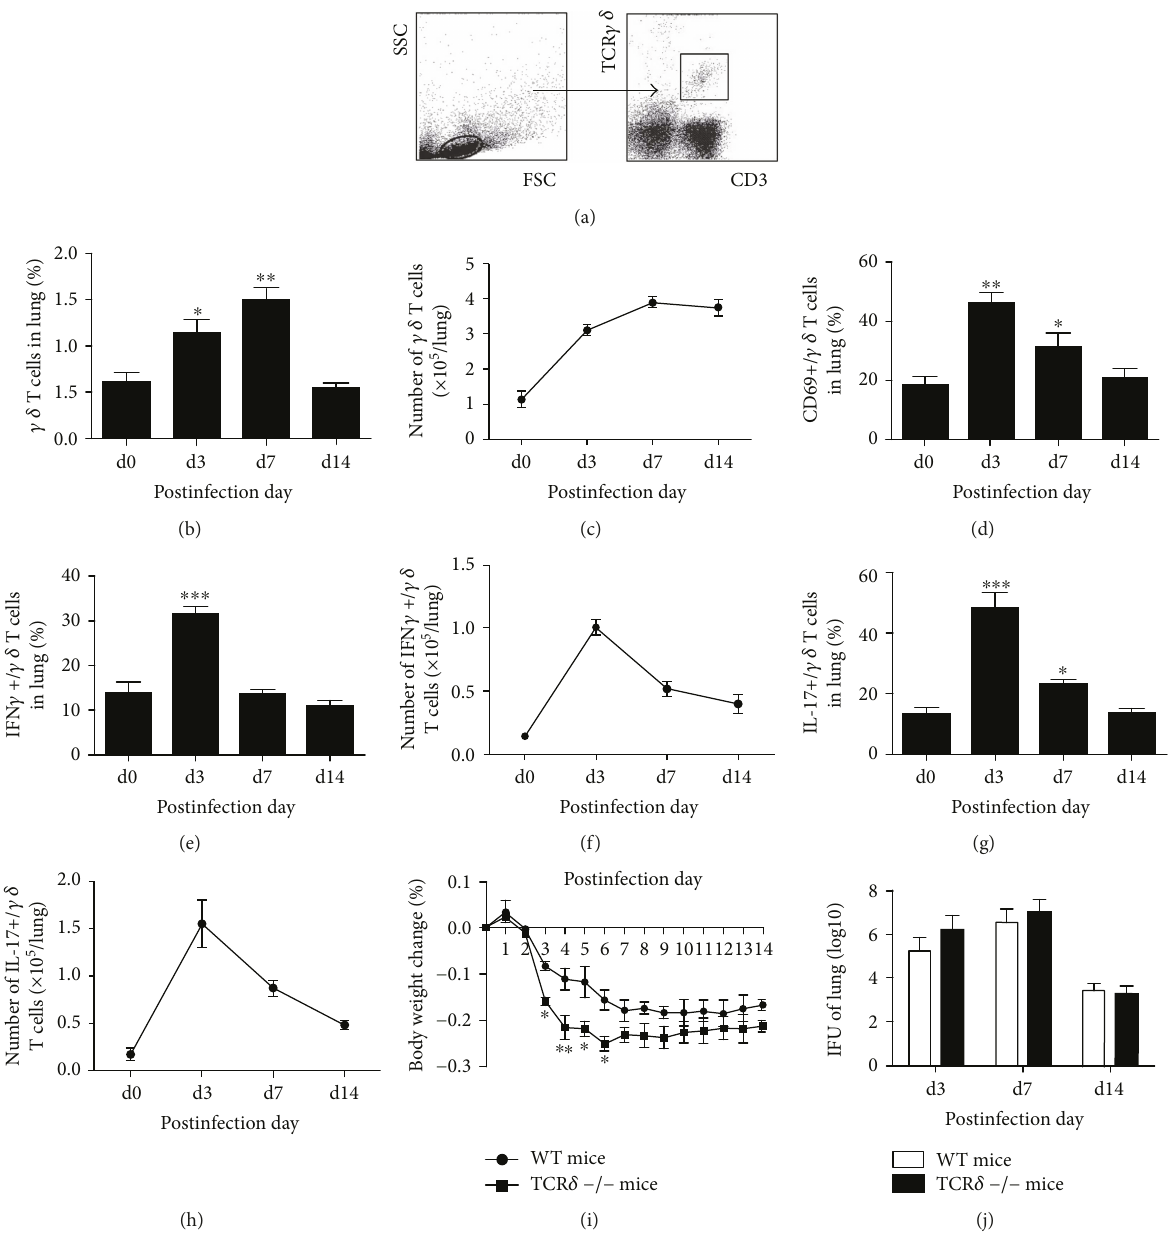
Figure 1: γδ T cells provided immune protection against Cm infection by expansion, activation, and secreting IFN γ and IL-17 . The mononuclear cells from WT mice (four/group) killed at speci fi c time points following C. m uridarum infection (1 × 10 3 IFUs) were extracted from the lungs. In gated lymphocytes (a), percentage (b), and absolute number (c) of CD3+ TCR γδ + T cells, expression level of CD69 on CD3+ T CR γδ + T cells (d), percentage (e, g), and absolute number (f, h) of IFN γ /IL-17-produing γδ T cells were analyzed and calculated by fl ow cytometry. WT and TCR δ − / − mice (four/group) were infected intranasally with C. muridarum (1 × 10 3 IFUs). Body weight changes (i) were monitored daily, and pulmonary C. muridarum (j) were assessed at day 3, day 7, and day 14 p.i. as mentioned in Materials and Methods. Shown are the representative data of two independent experiments with similar results presented as mean ± SD. ∗ p < 0 05 , ∗∗ p < 0 01 , and ∗∗∗ p < 0 001